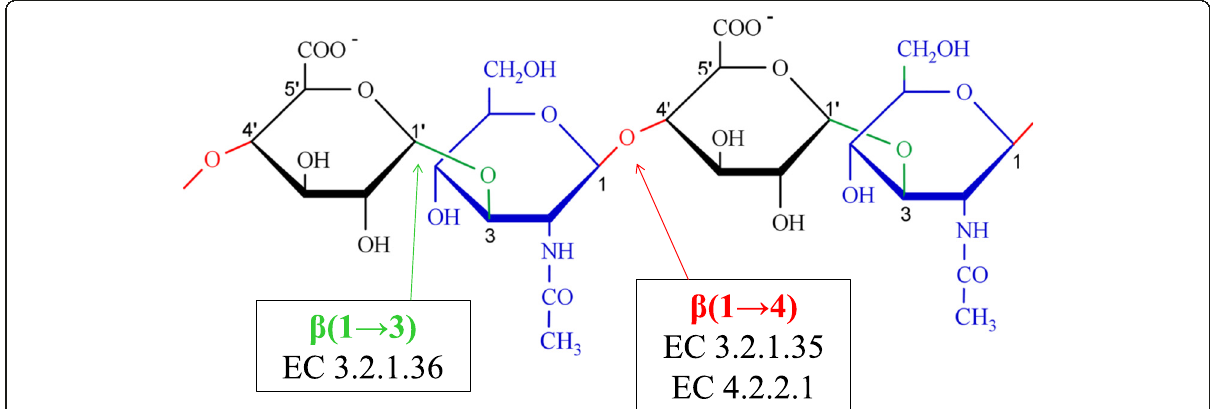
Fig. 1 Structure of hyaluronan. The repeating disaccharide units of N -acetyl- β -D-glucosamine (GlcNAc) and β -D-glucuronic acid (GlcUA) linked via alternating β -1,3 (highlighted in green) and β -1,4 glycosidic bonds (highlighted in red) are shown. The hyaluronidases EC 3.2.1.36 cleave the β -1,3 glycosidic bond, EC 3.2.1.35 the β -1,4 glycosidic bond and the EC 4.2.2.1 the β -1,4 glycosidic bond by elimination, yielding a double bond between carbons 4 ’ and 5